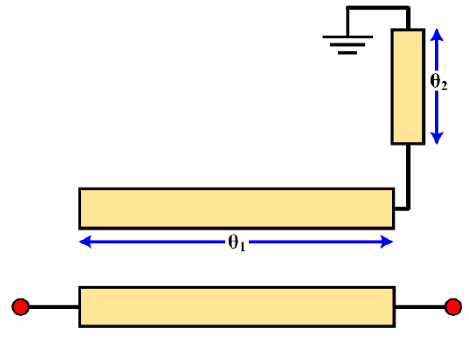
Figure 3. Coupled bent resonator.